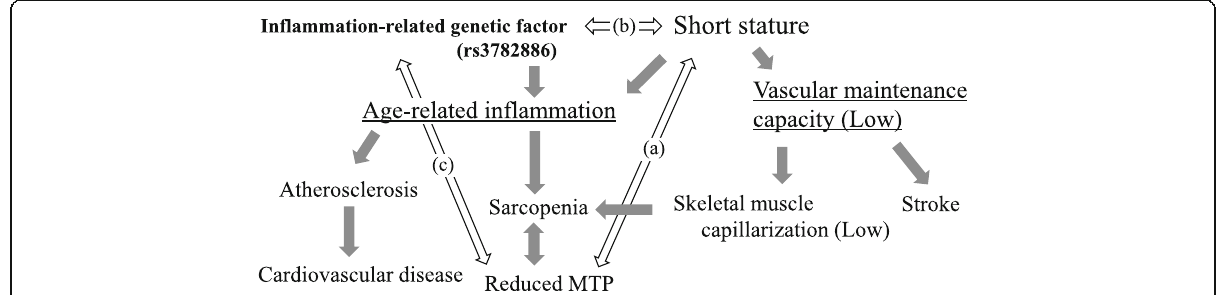
Fig. 1 The possible mechanism underlying the positive association between short stature and reduced MTP and the role of SNP rs3782886. In our present study, a short stature was positively associated with reduced MTP, b rs3782886 minor homo was positively associated with short stature, and c rs3782886 minor homo was positively associated reduced